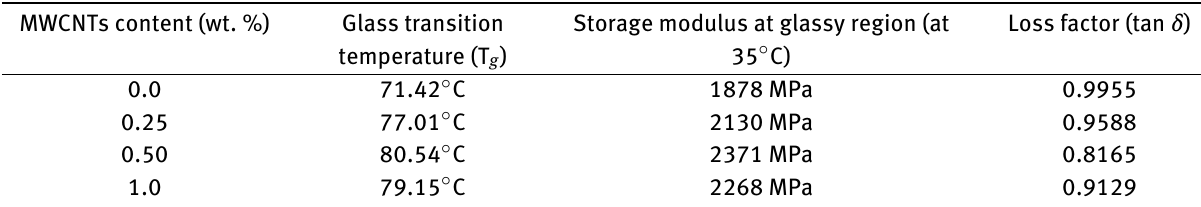
Table 2: Glass transition temperature (T g ), storage modulus (MPa) and loss factor (tan δ ) of neat epoxy and epoxy nanocomposite with different weight percentage of MWCNTs MWCNTs content (wt.